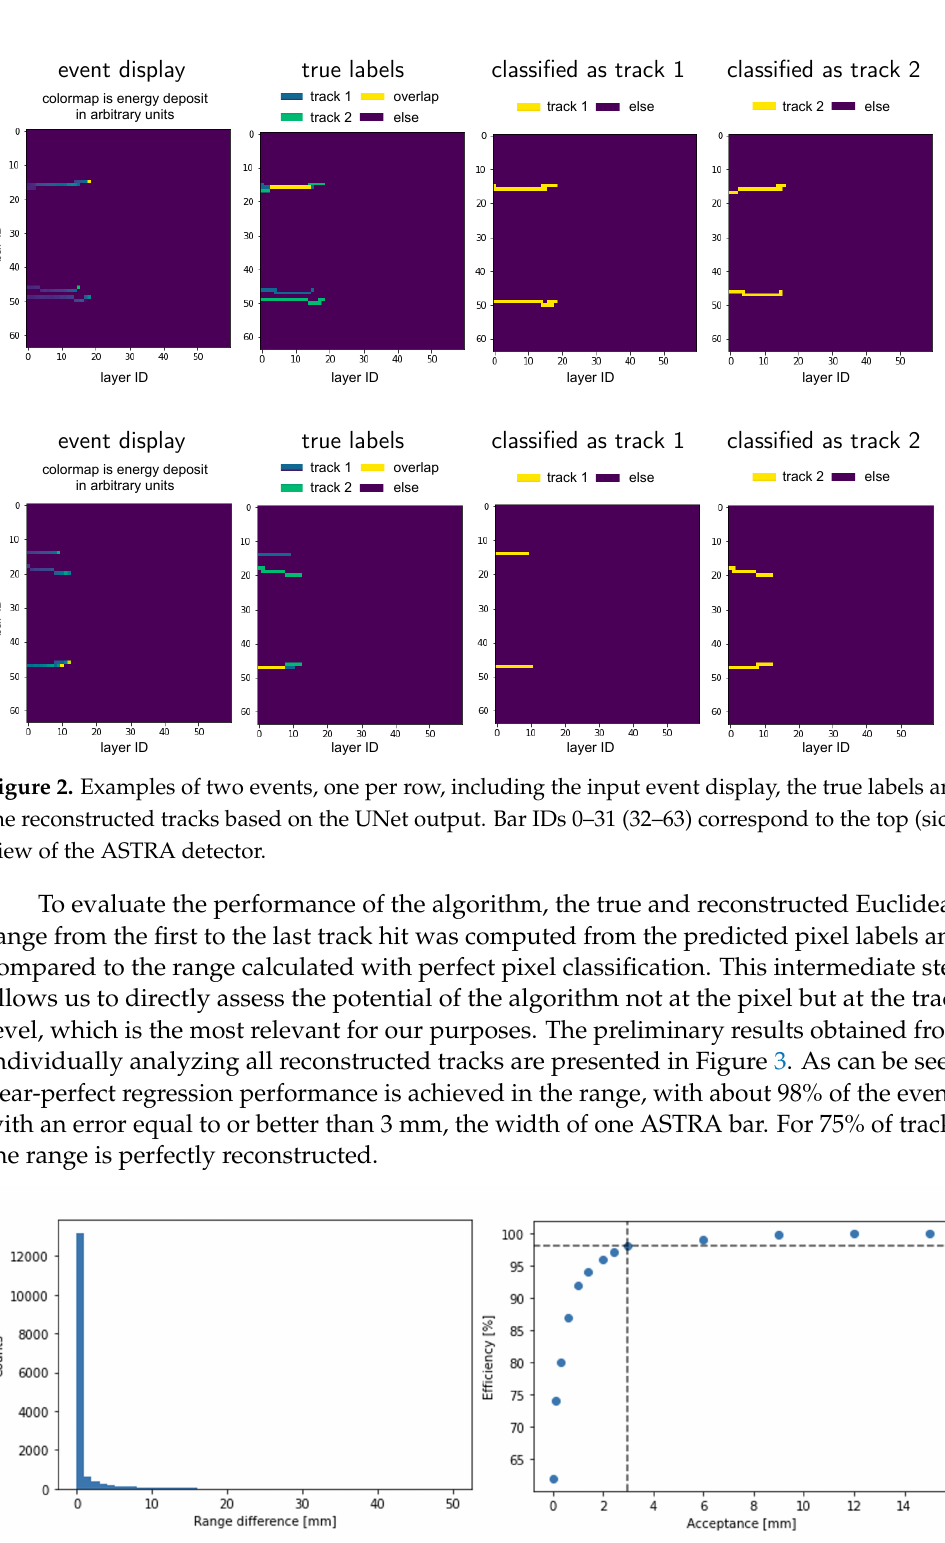
Figure 3. ( Left ): Distribution of the difference between the reconstructed range using the true pixel information compared to that calculated using predictions from the UNet-based tracking algorithm. ( Right ): Fraction of tracks with an error smaller than an acceptance cut for the distribution on the